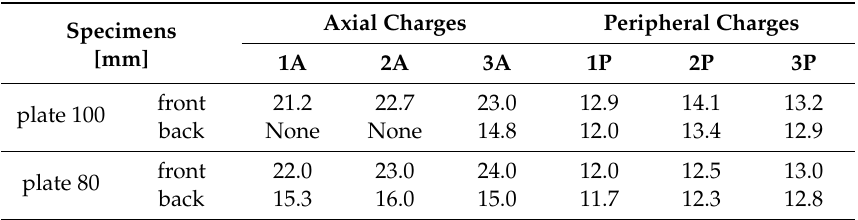
Table 2. A list of the diameters of the entrance and exit holes from a shaped charge.